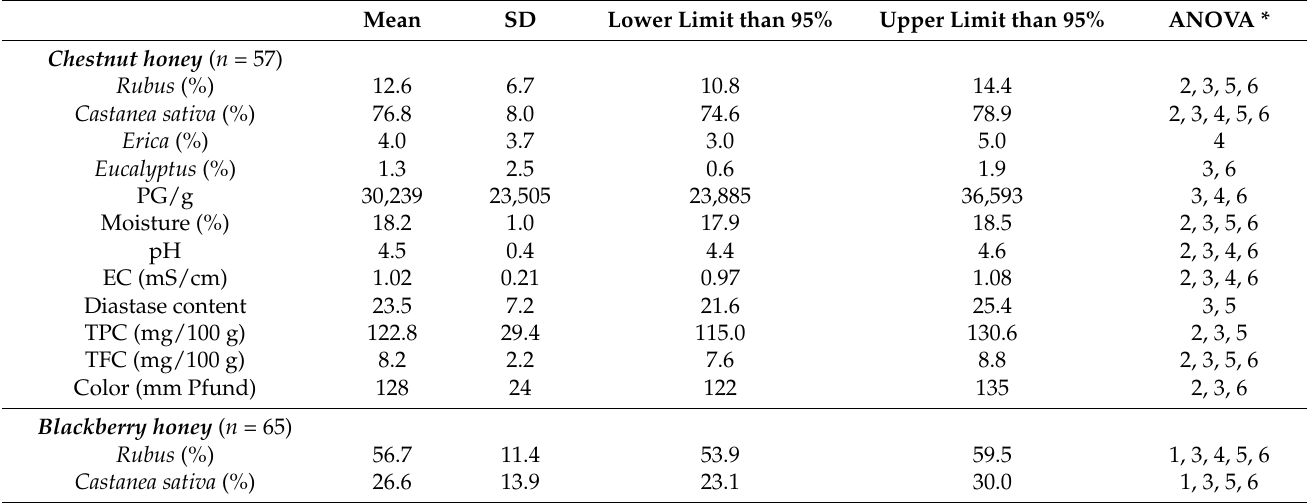
Table 6. Descriptive analysis of the botanical and physicochemical characteristics by honey type based on LDA. * The numbers show significant differences in the means for each honey type